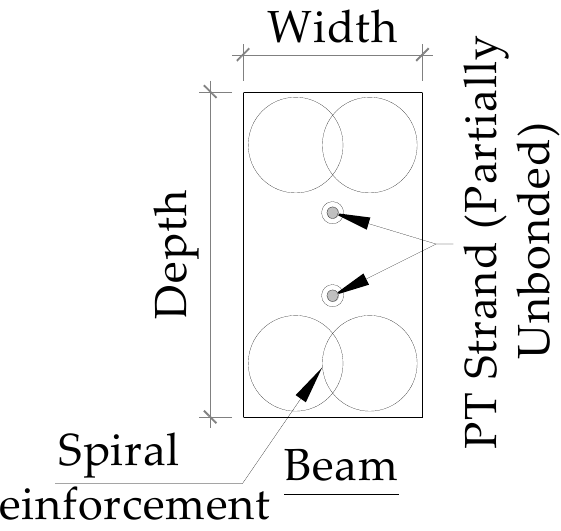
Figure 16. PT strand placed closer to the center and partially unbonded.